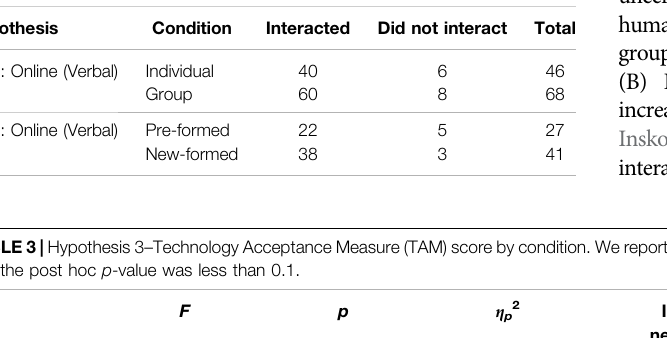
TABLE 2 | Descriptive statistics for H1C and